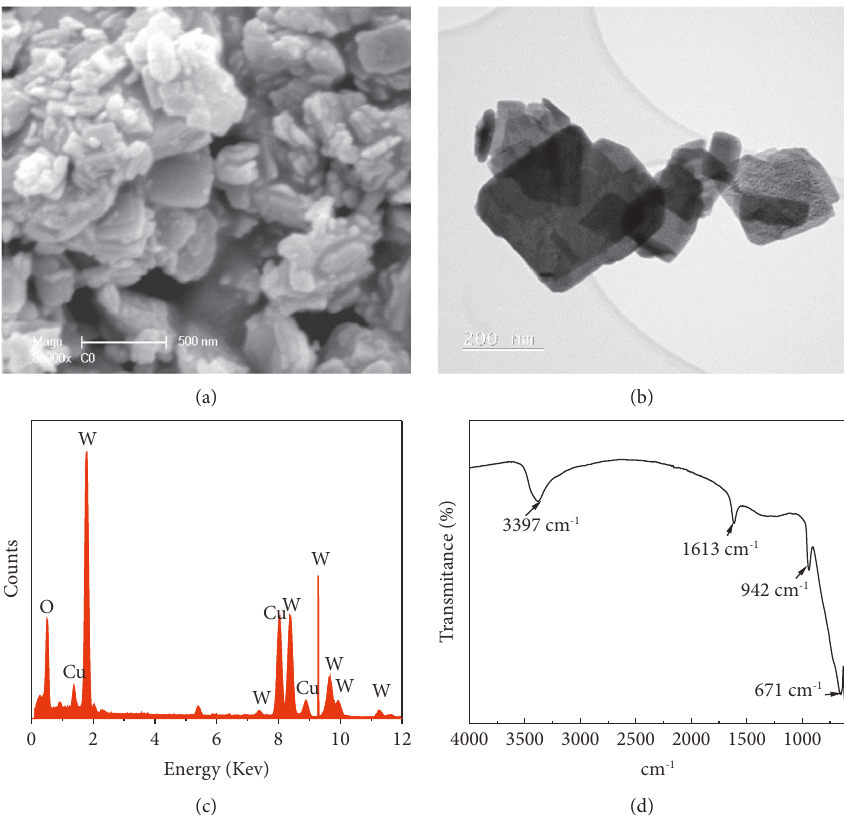
Figure 2: (a) SEM image of tungsten oxide synthesized, (b) TEM image of tungsten oxide synthesized, (c) EDS spectrum of tungsten oxide synthesized, and (d) FT-IR spectrum of tungsten oxide synthesized.